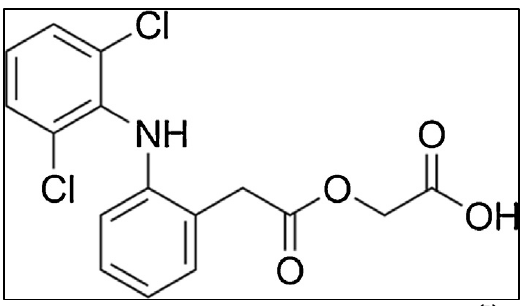
Figure 1. Chemical structure of Aceclofenac (5) Hydrogel is a water-swollen, cross-linked polymeric network formed by the simple reaction of one or more monomers (7)